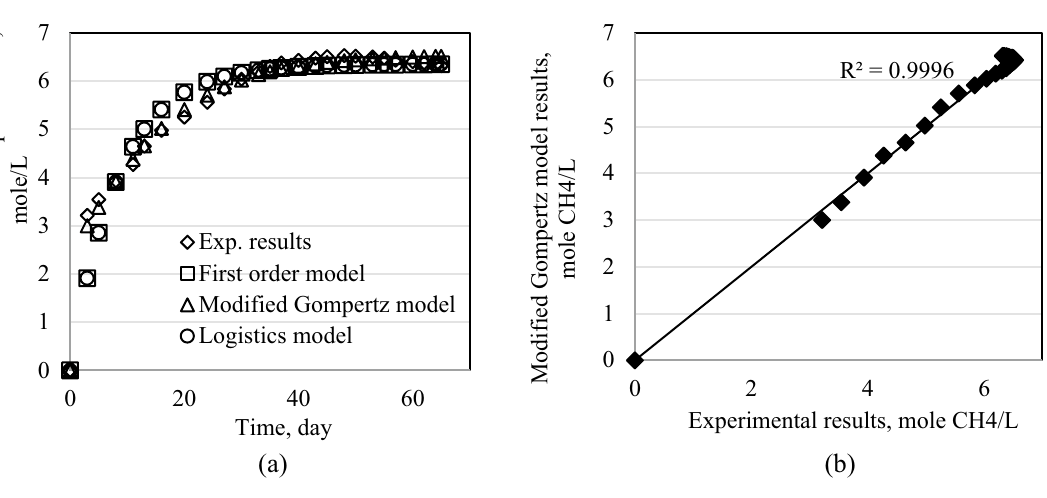
Figure 12. Results of models for Exp5. ( a ) Cumulative methane production for all models. ( b ) Modified Gompertz model results.